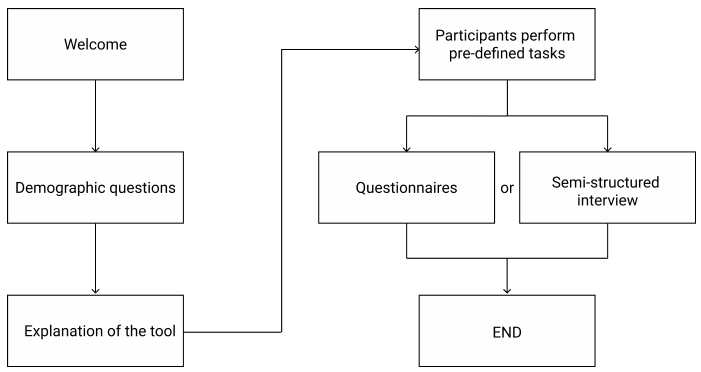
Figure 11. An overview of the evaluation